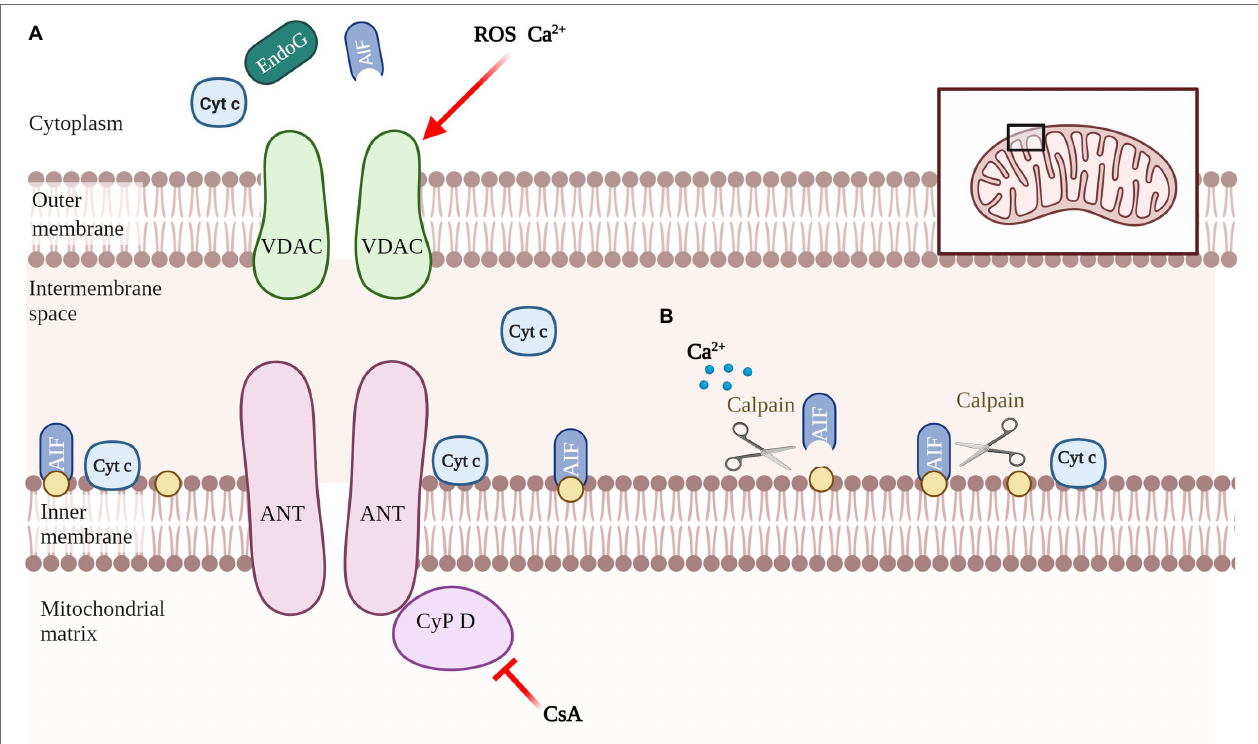
FIGURE 4 | Schematic of mediating the release of apoptotic molecules. Composition of the nonspecific pore complex of MPTP, which triggers mitochondrial swelling and apoptotic molecules release. (A) . Involvement of calcium/calpain in AIF-activated processing (B)